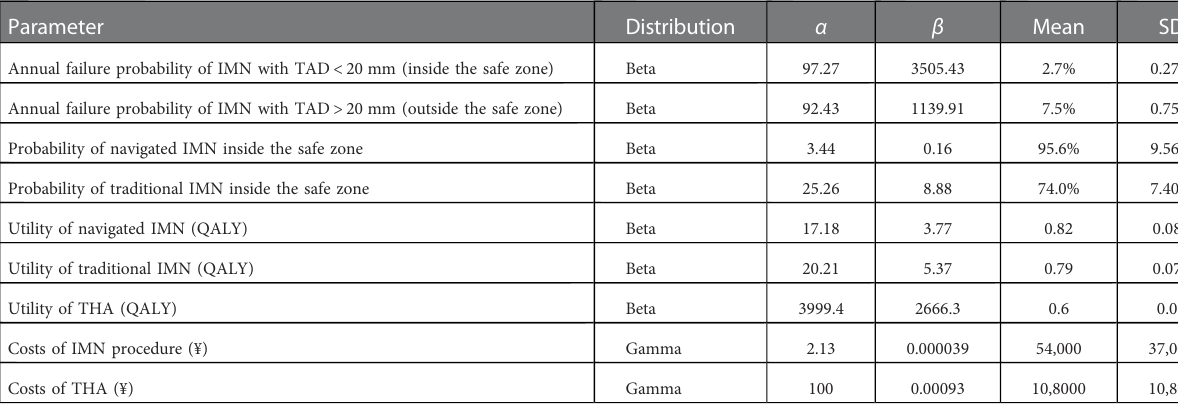
TABLE 2 Parameters for probabilistic sensitivity analysis with monte carlo simulation.